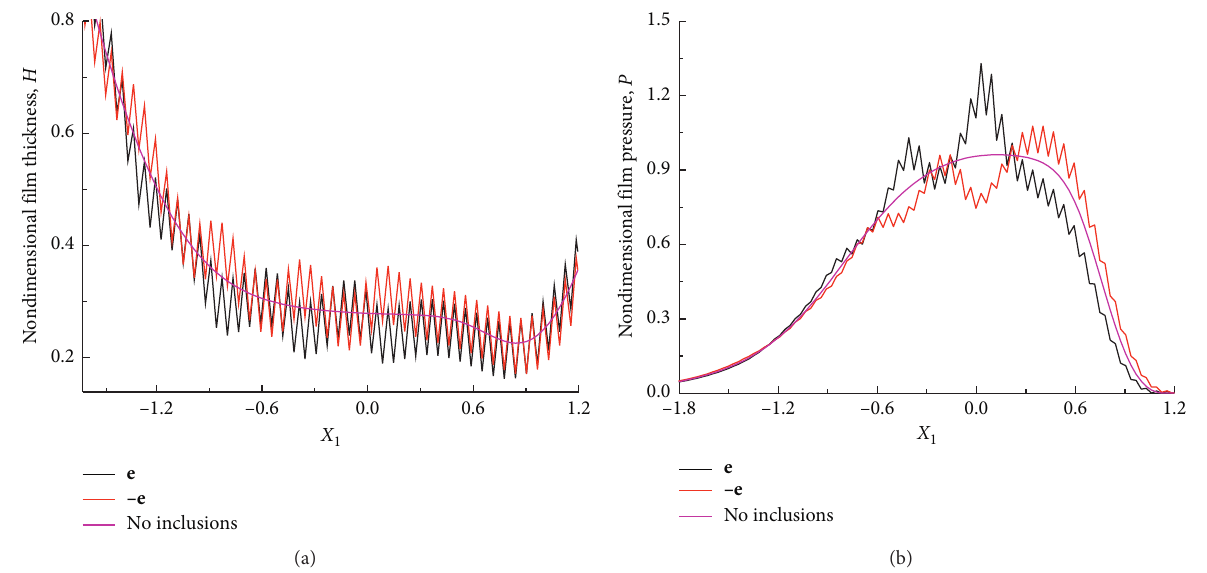
Figure 6: Nondimensional film thickness and pressure of the saw-tooth rough surface with particle eigenstrains, e and –e